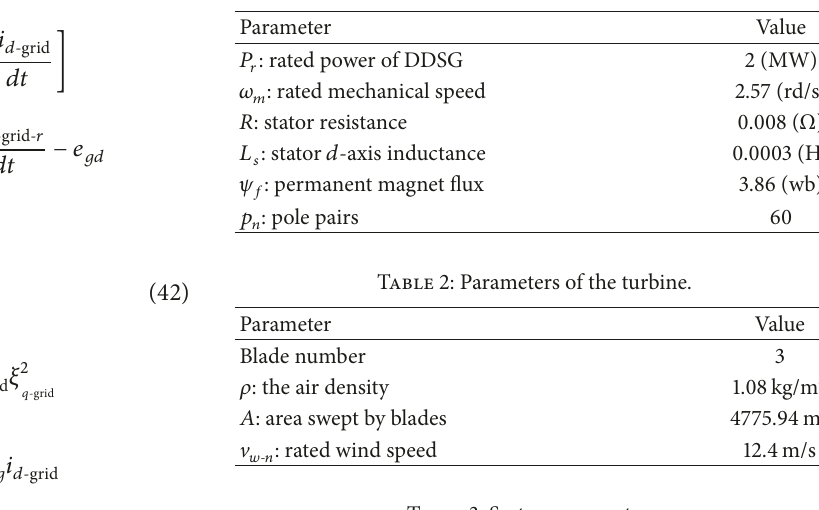
Table 1: Parameters of the DDSG.